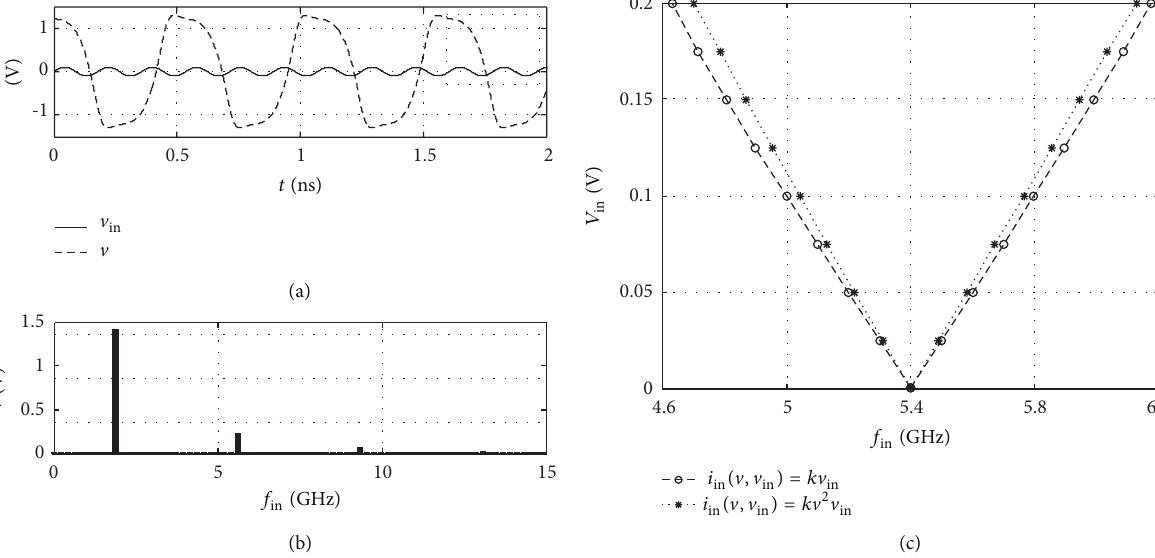
Figure 4: SPICE simulations of the circuit in Figure 3(b) with 𝑖 −32 mA/V 2 , 𝐿 = 10 nH, 𝑅 = 905 Ω , 𝐶 = 635.45 fF, 𝑉 Frequency spectrum of the output signal. (c) Arnold tongues obtained by simulating the circuit in Figure 3(b) with 𝑖 ( V , V ) = 𝑘 V 2 V 𝑖 in in in